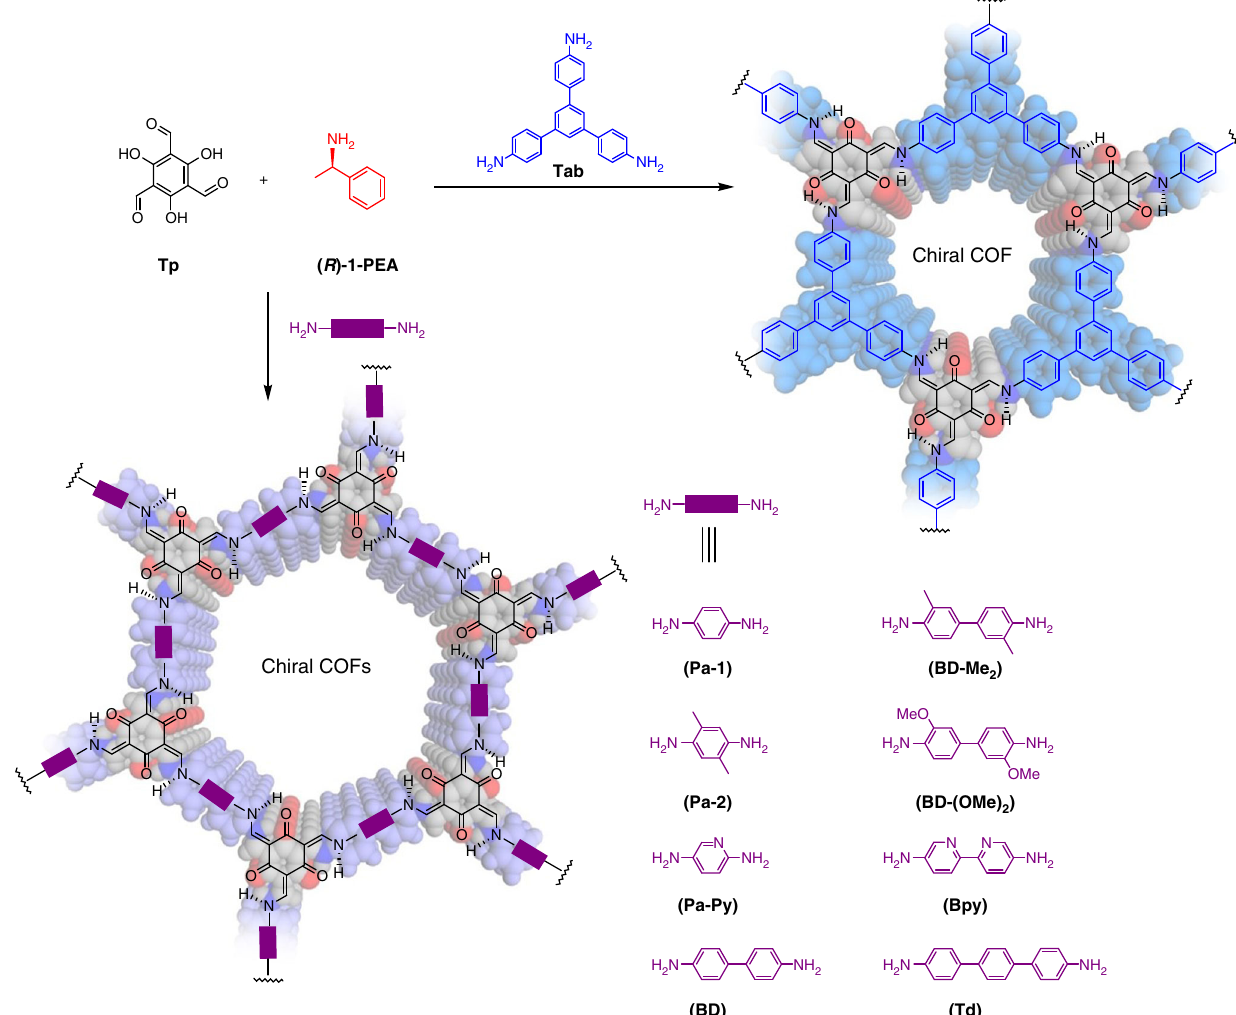
Fig. 2 Schematic representation of the synthesis of CCOFs. These CCOFs are formed from achiral precursors by chiral catalytic